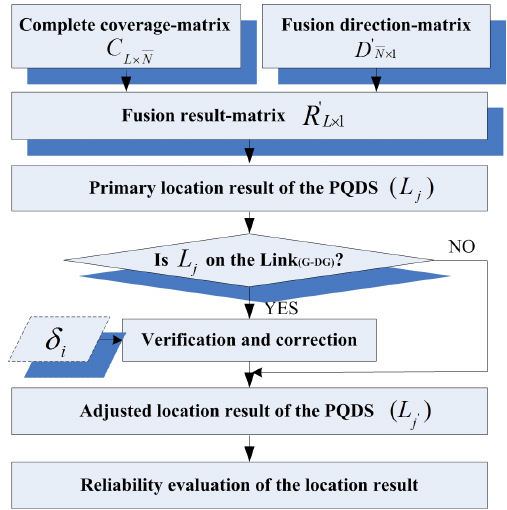
Figure 13. Basic process of decision-making and